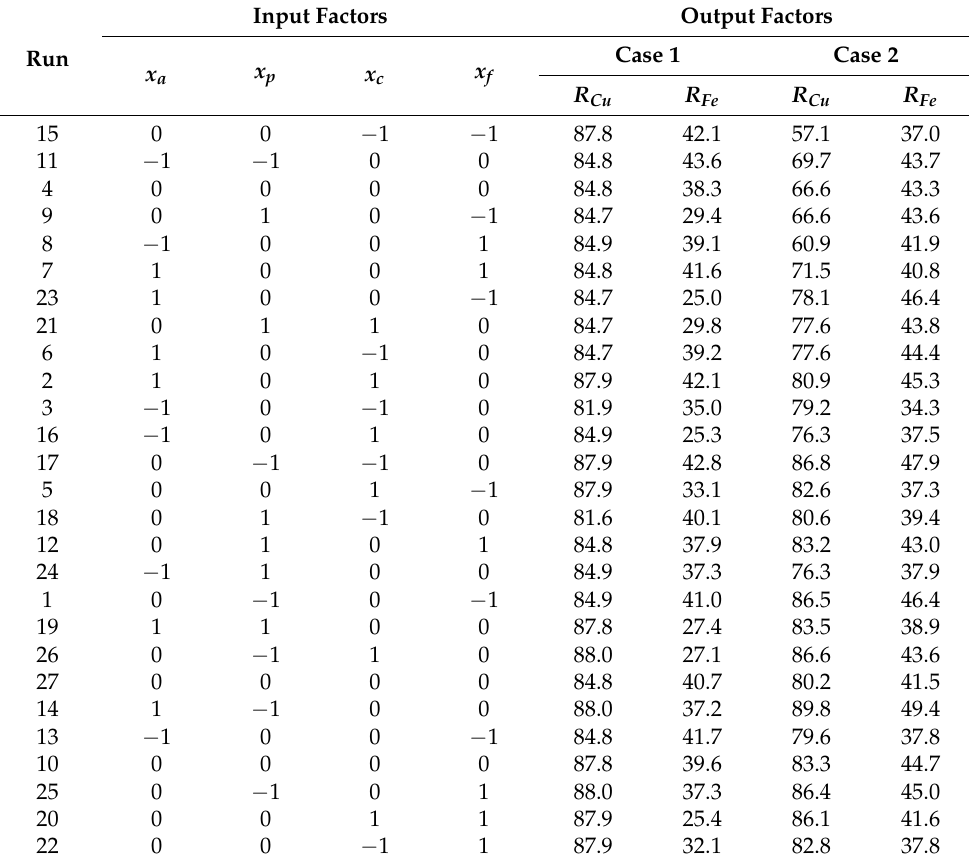
Table 7. Summary of BBD experimental results for Case 1 and Case 2